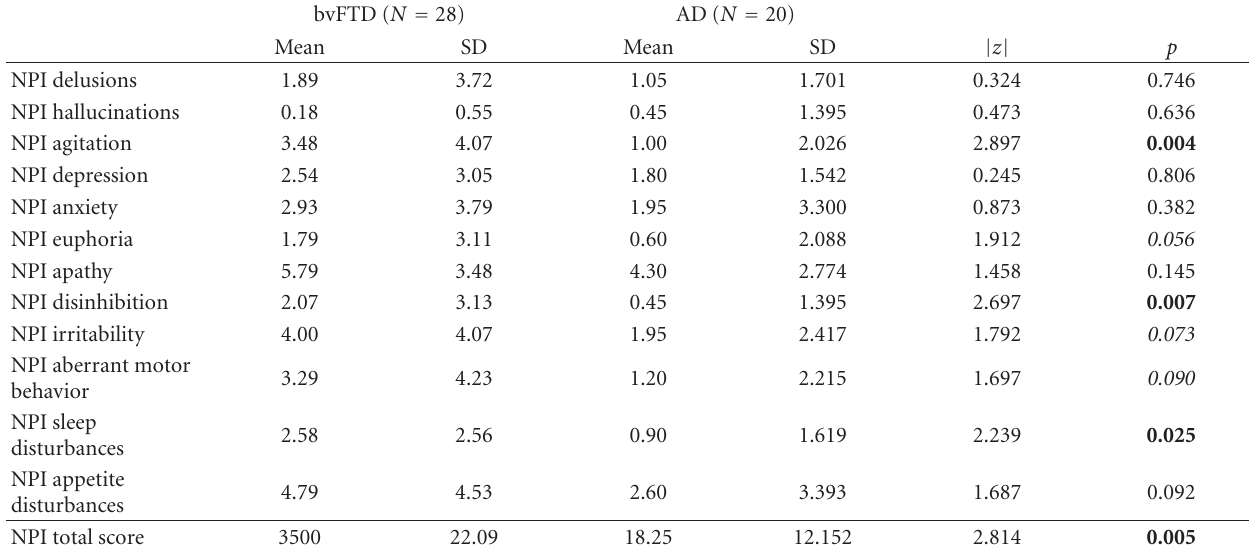
Table 2: Comparison of behavioral profiles of the two groups. Statistically significant di ff erences are indicated in bold; confounders included in the logistic regression analysis are reported in italics. NPI: Neuropsychiatric Inventory.